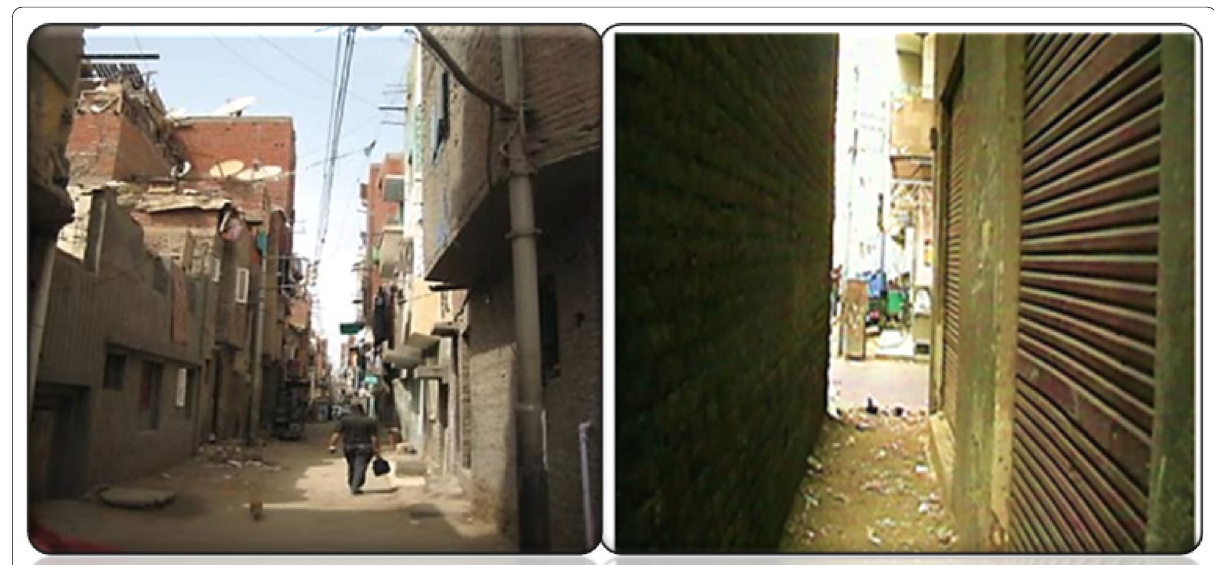
Fig. 6 Showing the Street narrowness and inconsistency with building